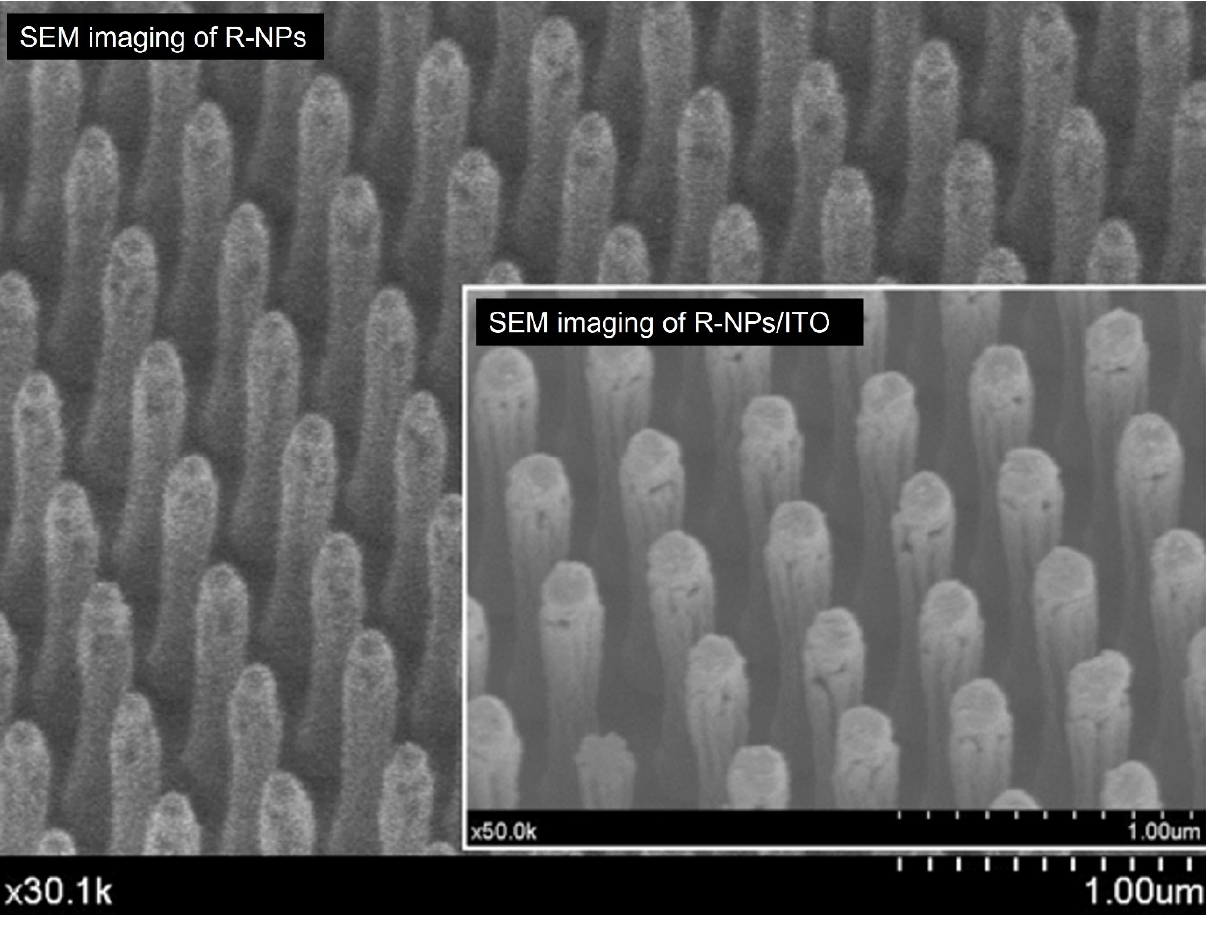
Figure 2. Comparison of SEM imaging of R-NPs and R-NPs/ITO.